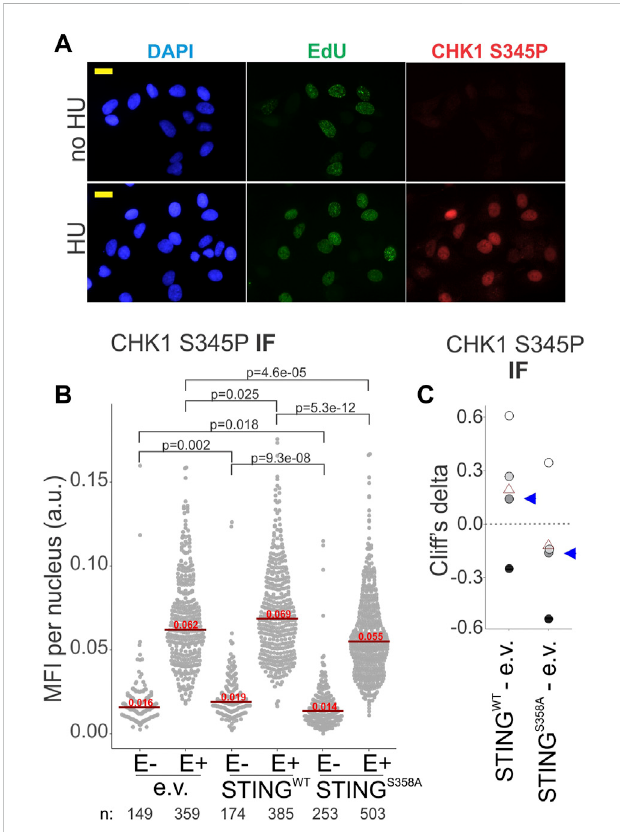
FIGURE 7 CHK1 activation is affected by STING status. (A) A representative image of CHK1 S345P and EdU immuno fl uorescence in HU-treated (5 mM HU/5 h) and untreated U2OS expressing wild type STING. Cells were treated as in Figure 6A. MFI, mean fl uorescence intensity, a.u, arbitrary units. Scale bar = 20 μ m. (B) IF images of CHK1 S345P were generated for the HU-treated U2OS cells with the indicated transgenes, and CHK1 S345P signal intensity was quanti fi ed. Signal intensities are shown separately for EdU-negative (E − ) and EdU-positive (E+) cells. Red lines are medians and their values are shown above the lines. p values were determined in KS tests. (C) Cliff ’ s delta values for MFI distribution differences between the indicated pairs of samples were calculated for two independent experiments with biological replicates (i.e., four sets total)quanti fi edasin (A) .Valuesderivedforeachsetareidenti fi ableby fi ll tone. Blue arrowheads identify the values from the experiment shown in (A) . p values are determined in KS